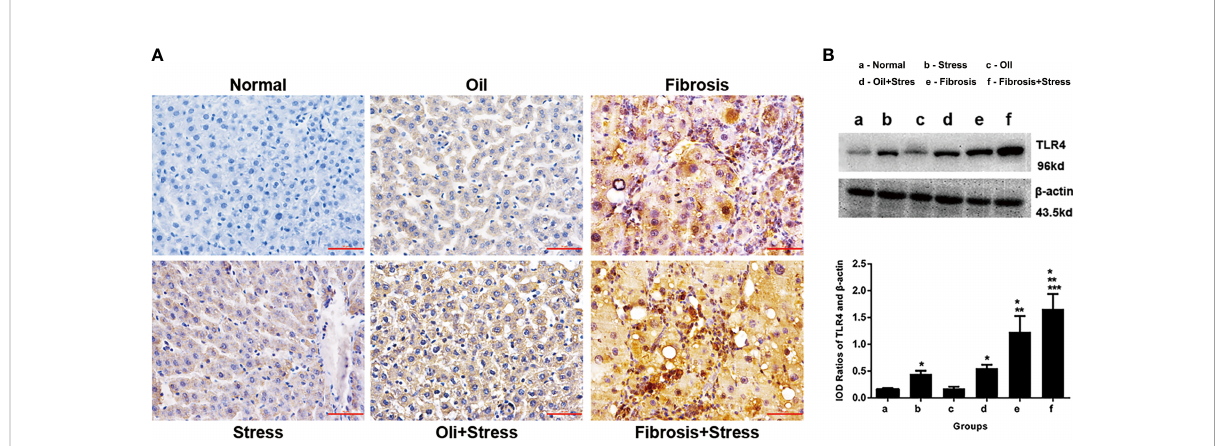
FIGURE 5 TLR4 protein expression in liver tissue of rats. (A) Immunohistochemical staining of TLR4 protein in liver tissue. Scale bar: 50um. (B) Western blot and quantitative analysis of TLR4 protein in liver tissue. (up) The typical image of TLR4 protein expression. (down) Quanti fi cation of TLR4 protein expression (IOD). Data are shown as means ± SD. * p < 0.05 vs. normal group and oil groups; ** p < 0.01 vs. stress group and oil+stree groups; *** p < 0.001 vs. fi brosis group. TLR4, toll-like receptor 4; IOD, integral optical density.